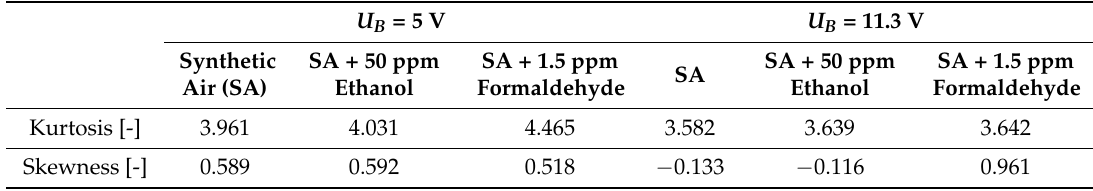
Table 1. Dimensionless kurtosis and skewness of voltage fluctuations across an AuNP-based gas sensor exposed to the shown gases at the stated bias voltages ( U B ). U B = 5 V U B = 11.3